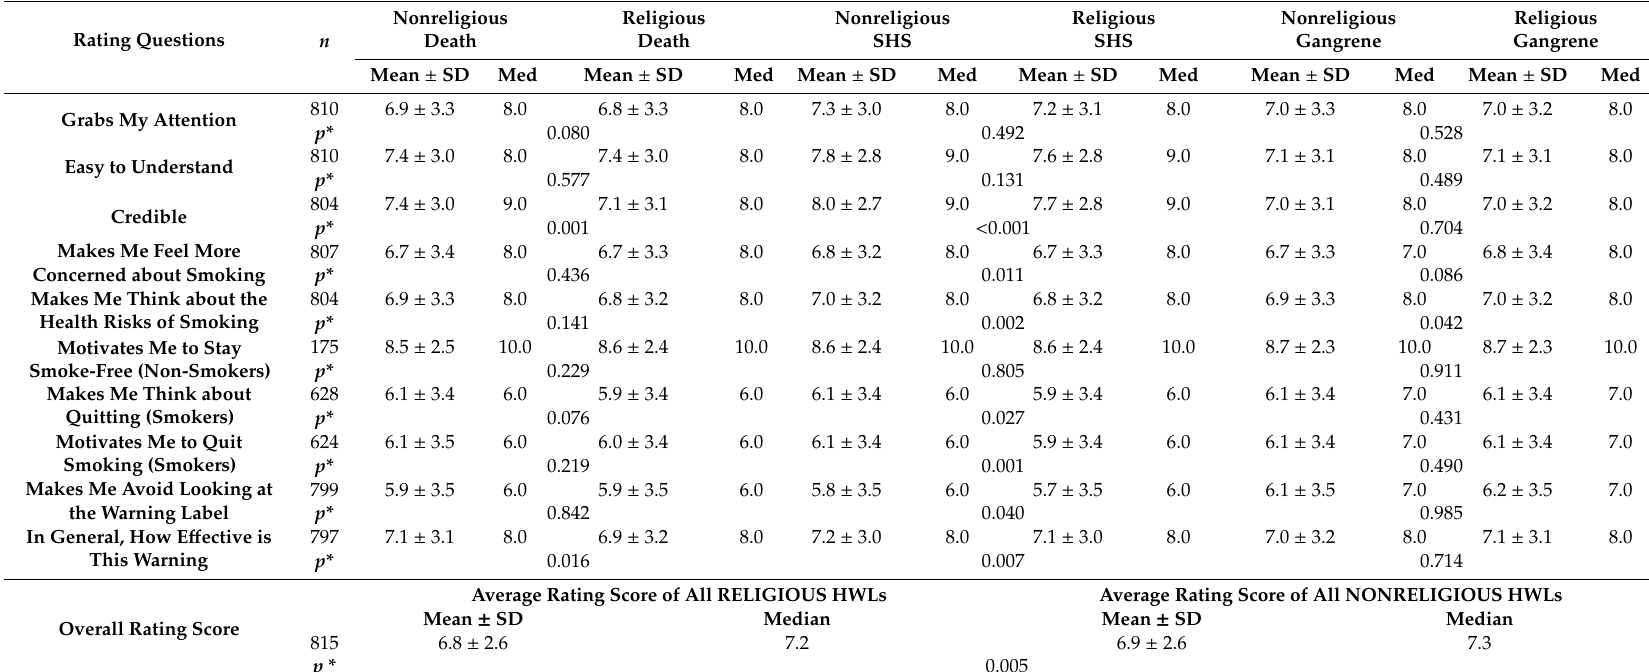
Table 3. Average Scores of the HWLs by the Rating